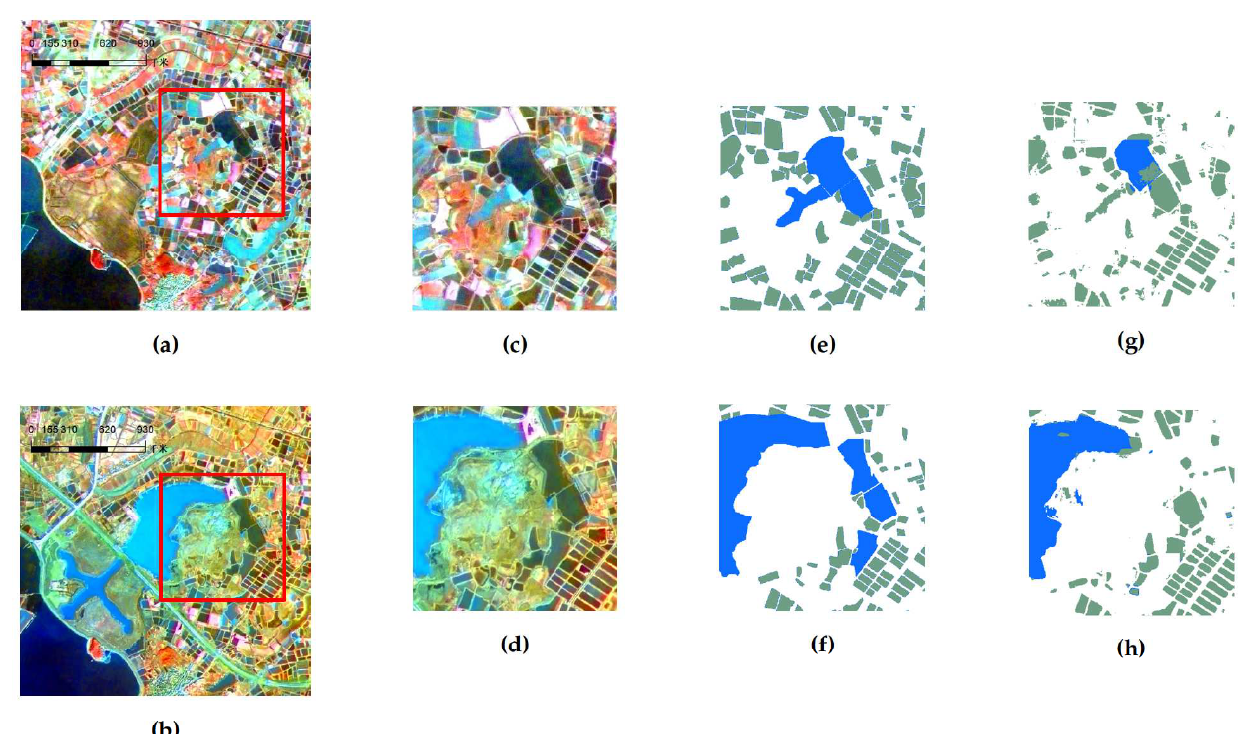
Figure 9. Influence of multi-year changes on semantic segmentation results for aquaculture ponds. ( a , b ) are pansharpened images of the significantly changed area from Region B in 2010 and 2014 respectively. ( c , d ) are magnified images. ( e , f ) are labelling images for ( c , d ). ( g , h ) are semantic segmentation results for ( c , d ) using the proposed